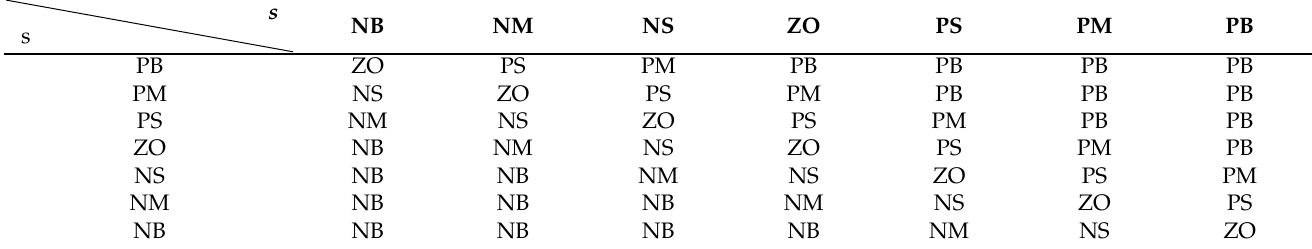
Table 1. Control rule